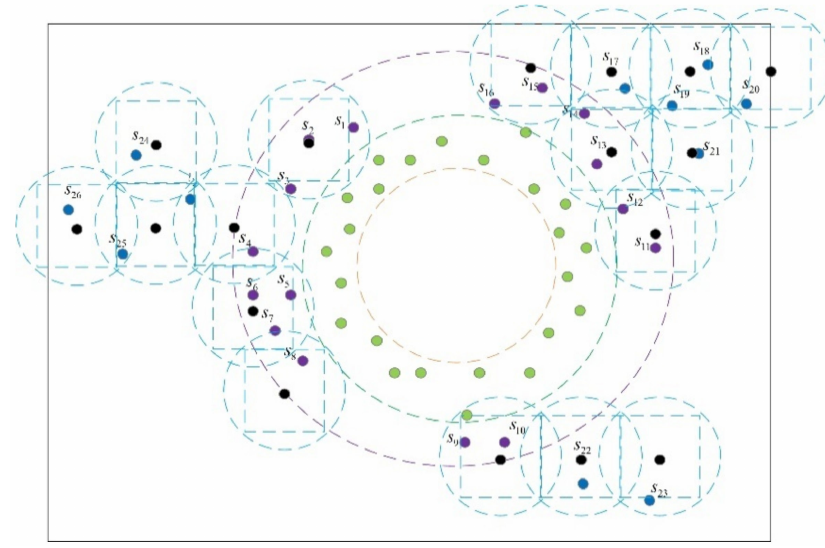
Figure 5. Deployment of pads with the static scheme.